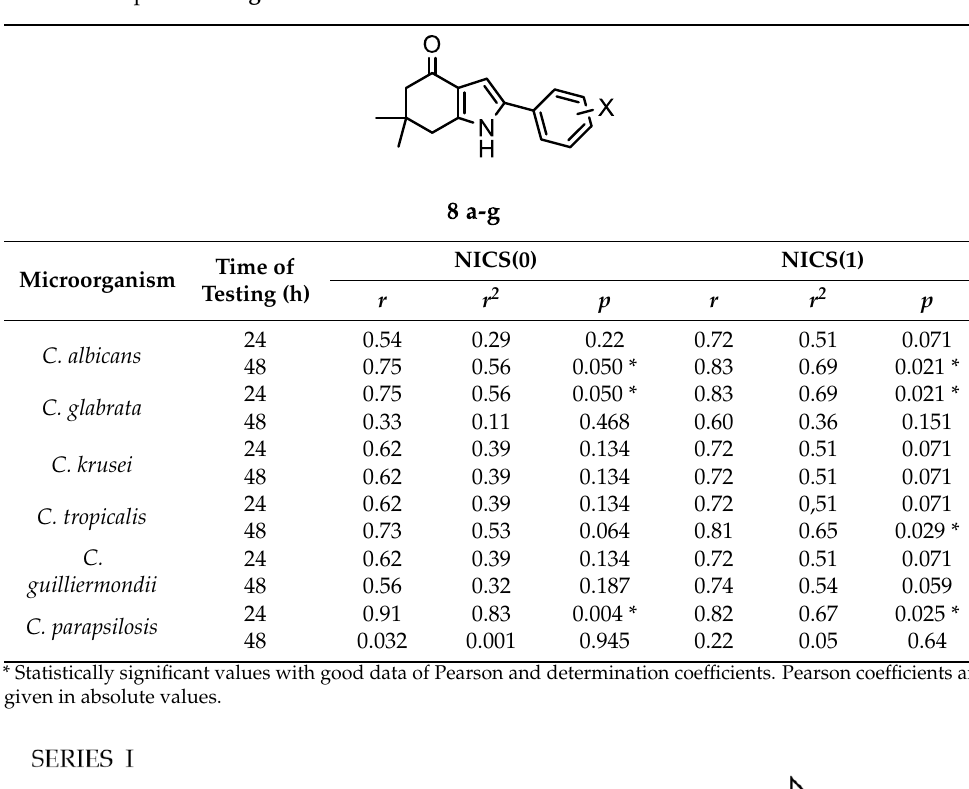
Table 3. Pearson and determination coefficients for simple linear regression NICS(0) and NICS(1) for series II: compounds 8a – g .